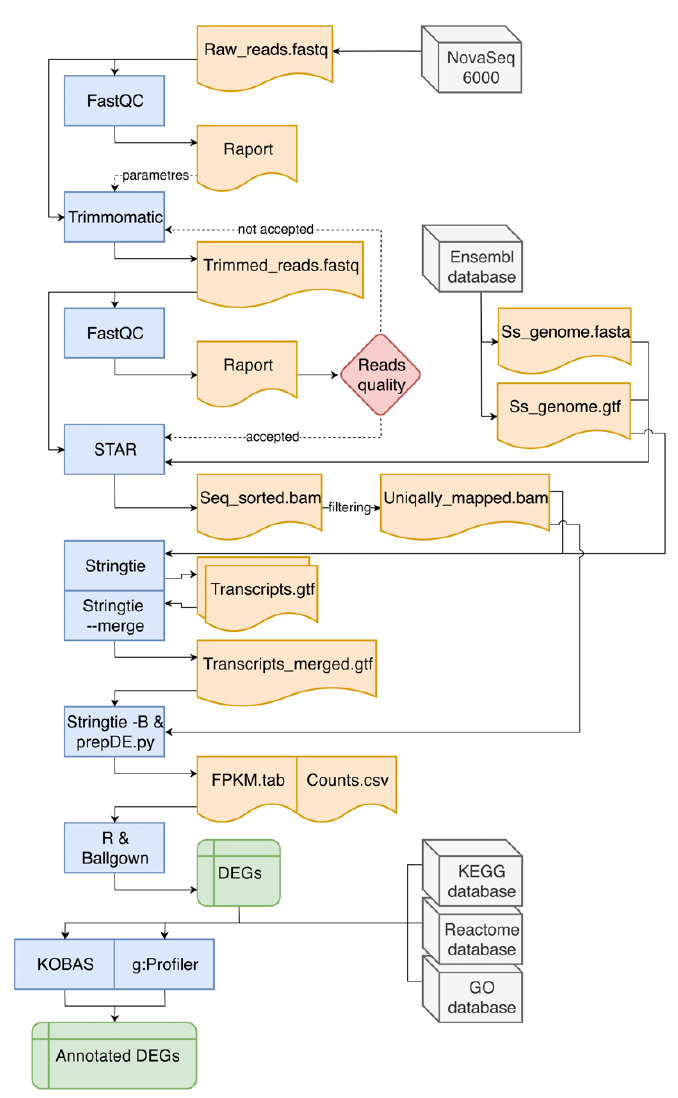
Figure 1. The course of in silico analyses. In the flowchart, blue blocks indicate used bioinformatic software, grey blocks represent databases (including the source of raw reads). Orange blocks symbolize input and output files necessary to run subsequent programs or tools. Green rectangles represent the result files that are the main effect of the entire data pipeline, which contain differentially expressed genes (DEGs). The red diamond symbolizes the decision-making process. Continuous arrows indicate the main direction of data flow, while intermittent arrows indicate the indirect influence on the analysis process.